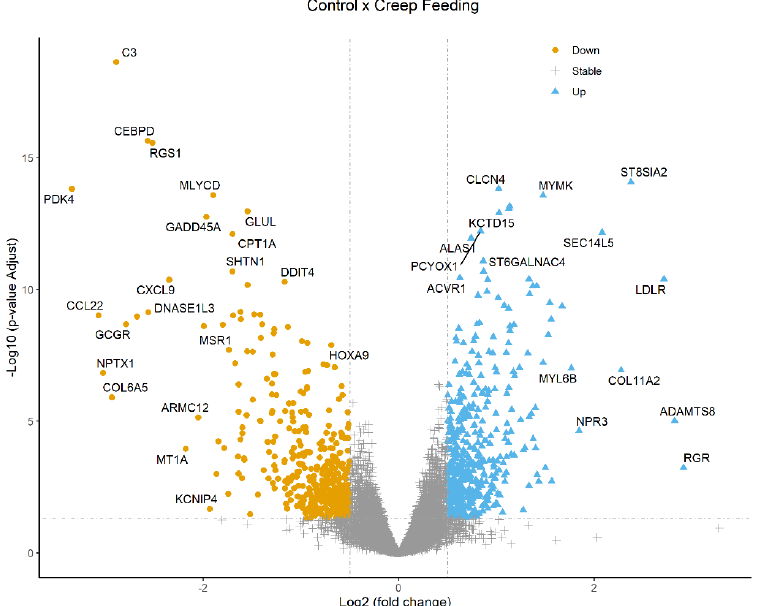
Figure 3. Volcano plot of log 2 fold change ( x -axis) versus -log 10 p -value (FDR, y -axis) indicating differences in DEGs identified by the edgeR method (downregulated: log 2 fold change < − 0.5 and FDR < 0.05; upregulated: log 2 fold change > 0.5 and FDR < 0.05) between G1 (control) × G2 (creep feeding) at weaning.